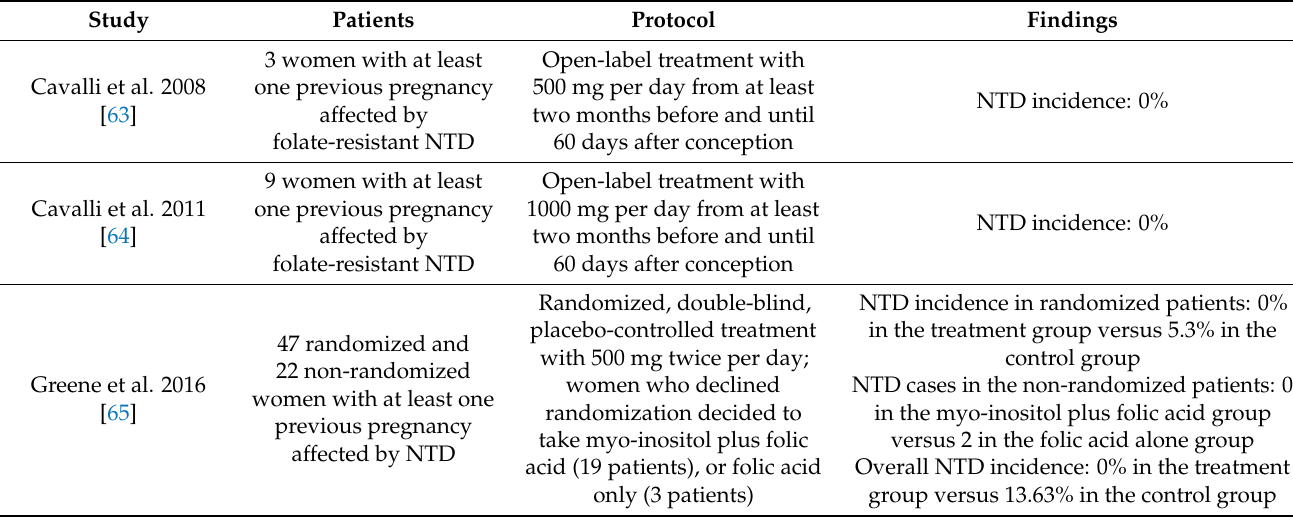
Table 4. Studies involving myo-inositol as a preventive treatment against NTDs in women with a previous pregnancy affected by NTD despite folate